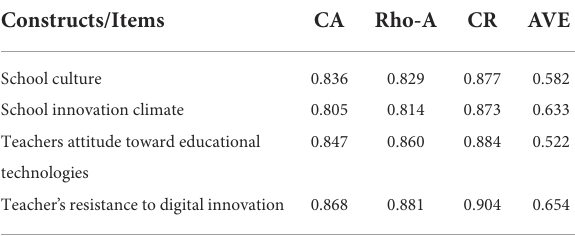
TABLE 2 Composite reliability, Cronbach’s alpha and AVE values.